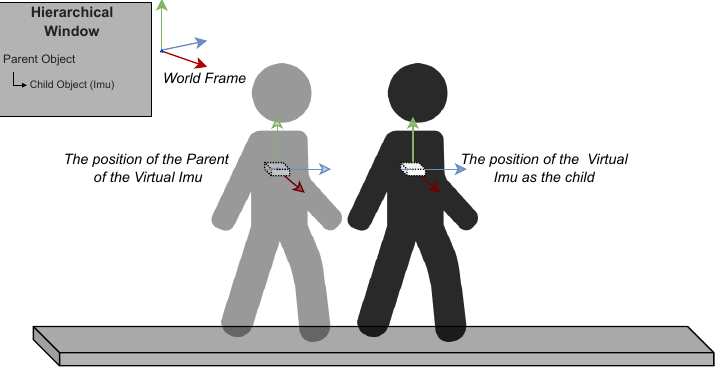
Figure 4. The parent-child relationship is adopted to obtain the position data in virtual IMU’s local